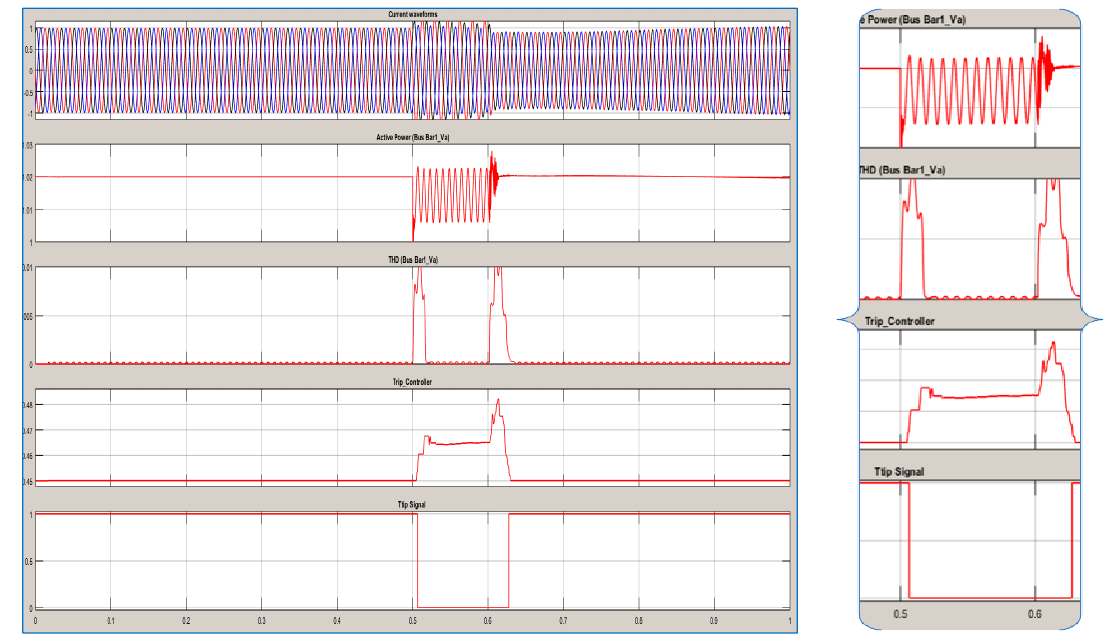
Figure 16. Double line (AB_G) fault current waveform.